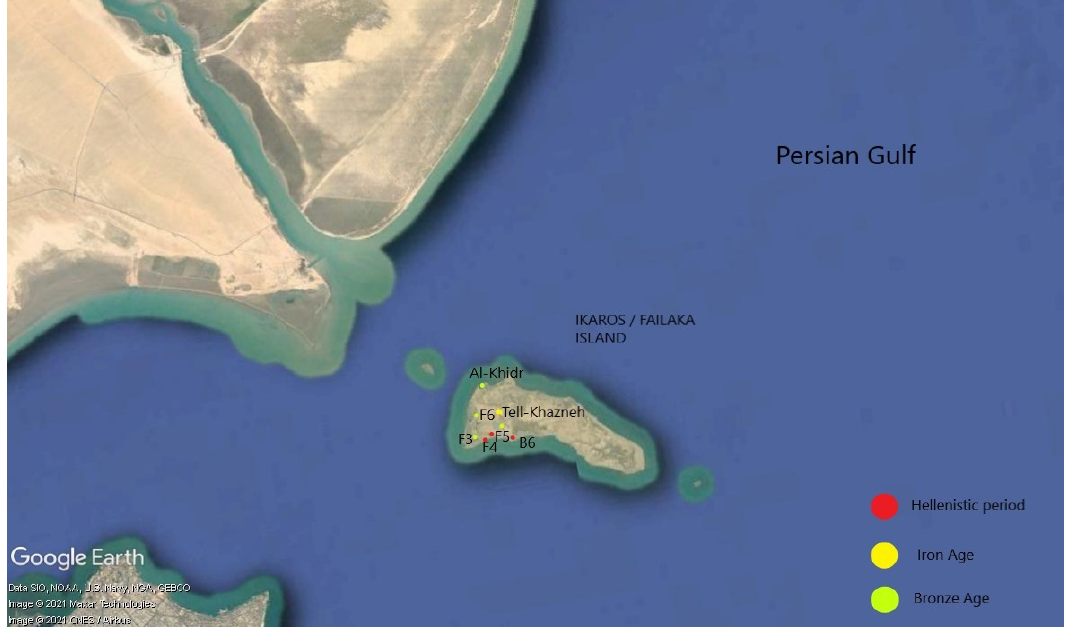
Figure 2. Map of Ikaros/Failaka. The map was created by the author using Google Earth Pro maps.